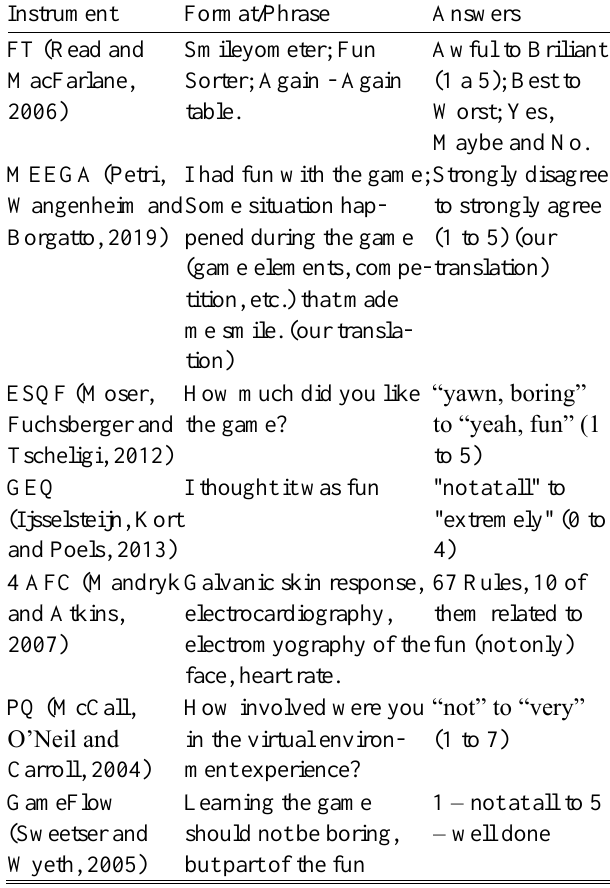
Table 6. Questioning used to measure